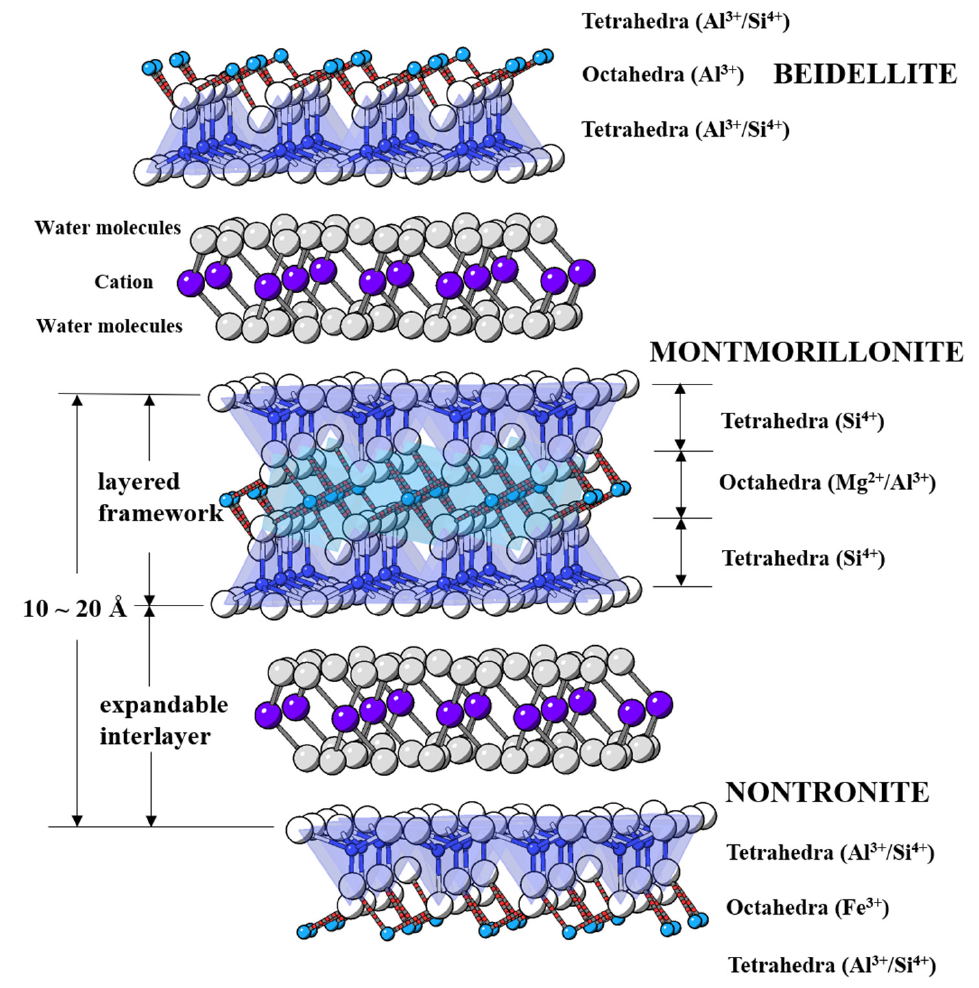
Figure 1. Schematic illustration of smectite structures represented by beidellite, montmorillonite, and nontronite. Blue and cyan colored circles represent the central cation in tetrahedra and octahedra comprising layered framework and white circles represent framework oxygen atoms, respectively. Purple and gray colored circles illustrate counterbalance interlayer cations and water molecules, respectively.